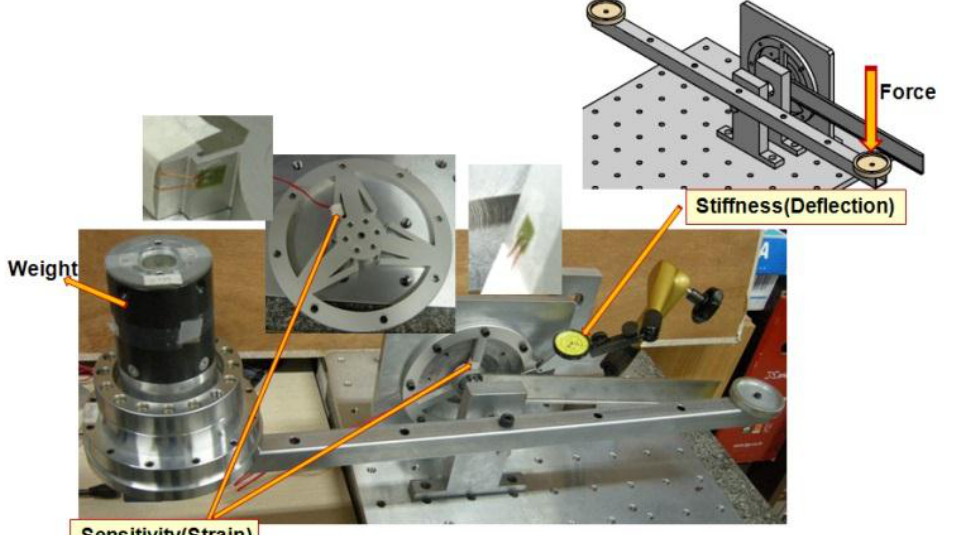
Figure 12. Experimental equipment.